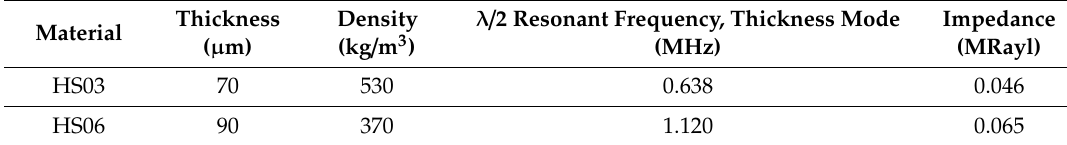
Table 1. Properties of the ferroelectret FE films employed